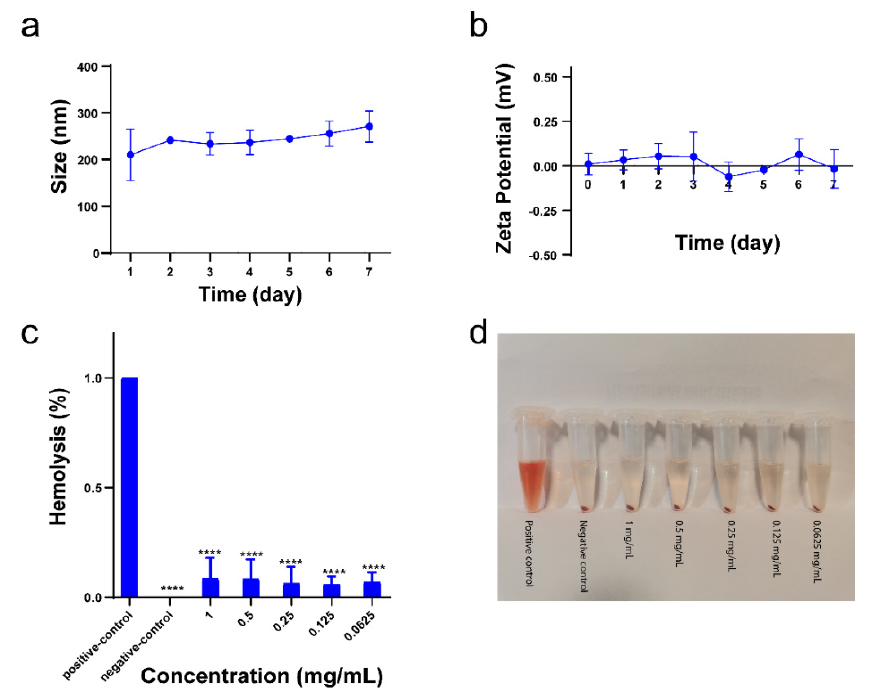
Figure 4. Stability and hemolysis of CaF 2 :Y,Gd,Nd NPs. ( a ) Size and ( b ) zeta potential of CaF 2 :Y,Gd,Nd NPs in 50% FCS; ( c ) hemolysis of CaF 2 :Y,Gd,Nd NPs after incubation with red blood cells at various concentrations (0 − 1 mg/mL) for 4 h; ( d ) hemolysis image after centrifugation. All experiments were conducted in three independent experiments and data are expressed as mean ± SD. Statistical significance was calculated by comparing the experimental group with the control group using one-way ANOVA (**** p < 0.0001).